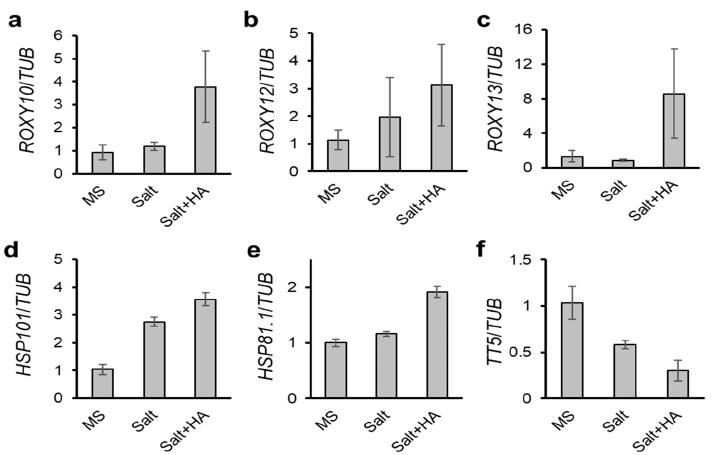
Figure 4. Validation of DEGs by qRT-PCR. One-week old Arabdopsis wild-type seedlings were treated with HA (860 mg L − 1 ), salt (100 mM NaCl), or salt + HA for 9 h. Transcripts of ROXY10 ( a ), ROXY12 ( b ), ROXY13 ( c ), HSP101 ( d ), HSP81.1 ( e ), and TT5 ( f ) were validated by qRT-PCR and normalized to that of TUB. Data represent means ± SE, n = 3.